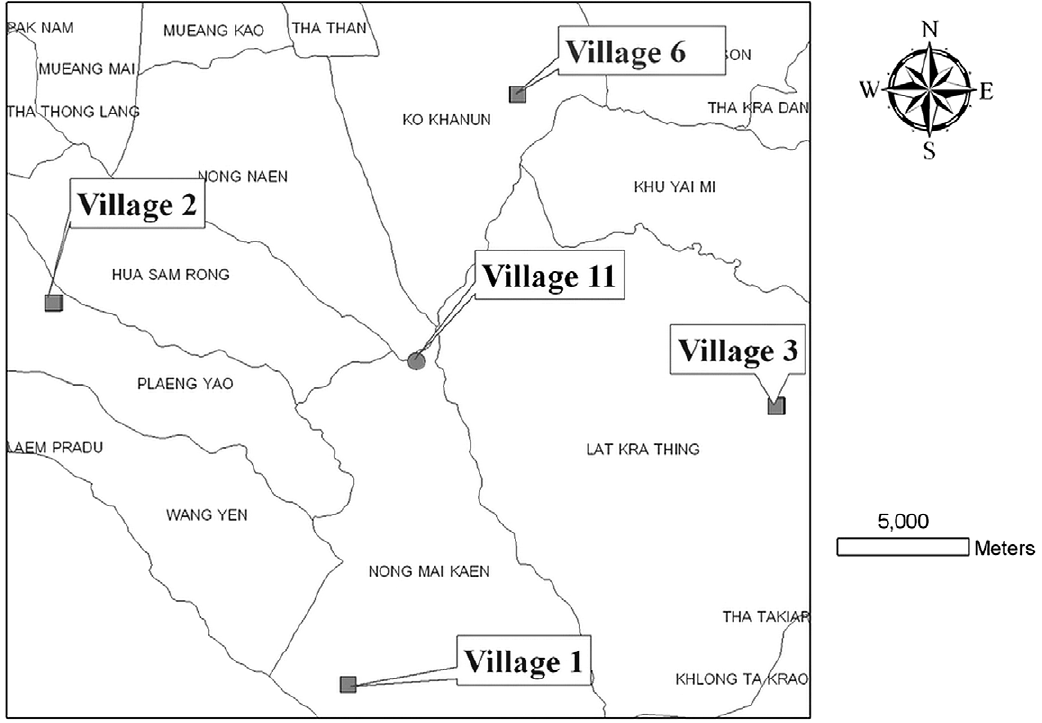
Figure 1. Complex of five villages in Hua Sam Rong Subdistrict of Plaeng Yao District, Chachoengsao Province, eastern Thailand, from which samples of Aedes(Stegomyia)aegypti (L.) were taken from December 2007 to September 2008.